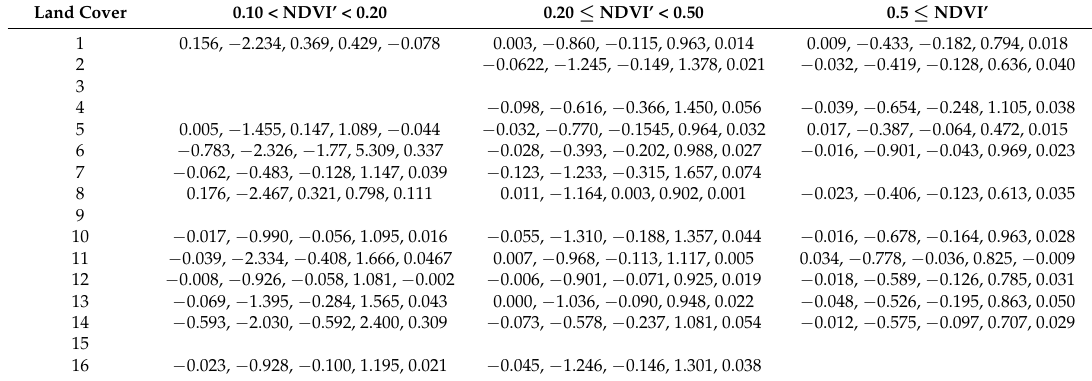
Table 8. Surface Reflectance Coefficients for 0.67 µ m for SON.